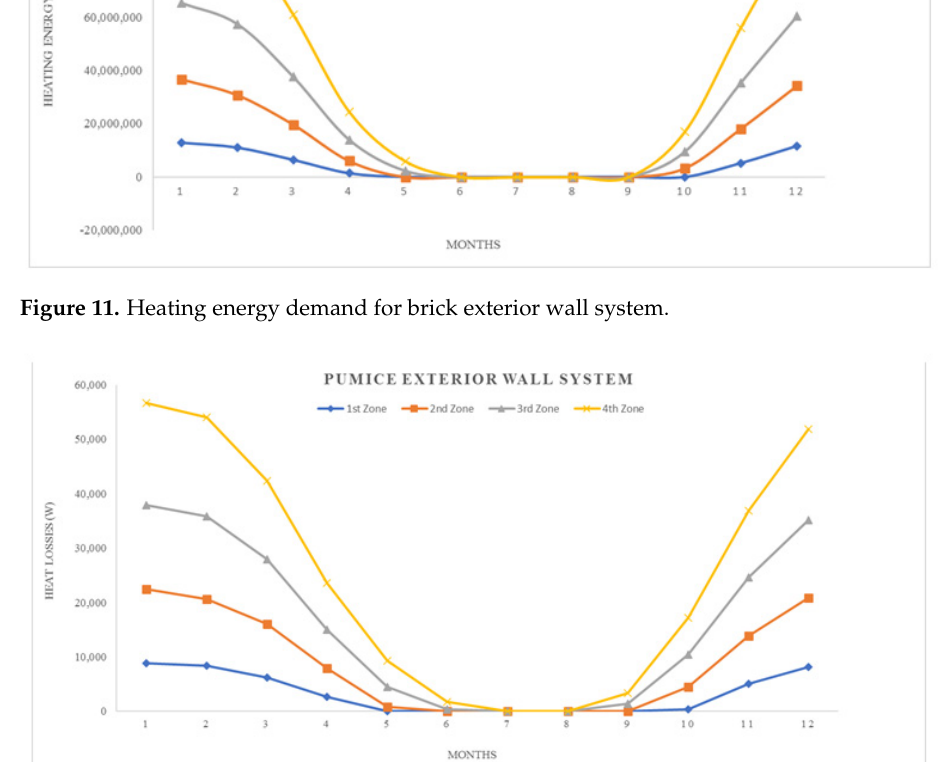
Figure 12. Heat losses for pumice exterior wall system .